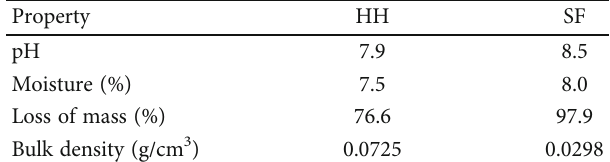
Table 1: Main properties of keratin-based biomaterials used in heavy metal removal.